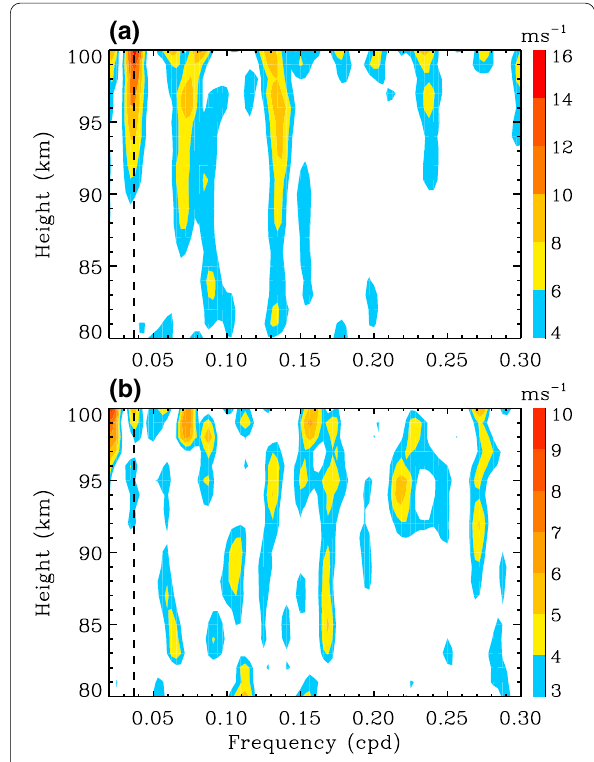
Fig. 2 Lomb–Scargle spectra of a zonal and b meridional winds observed by Maui meteor radar. The dashed vertical line corresponds to a period of 27 days